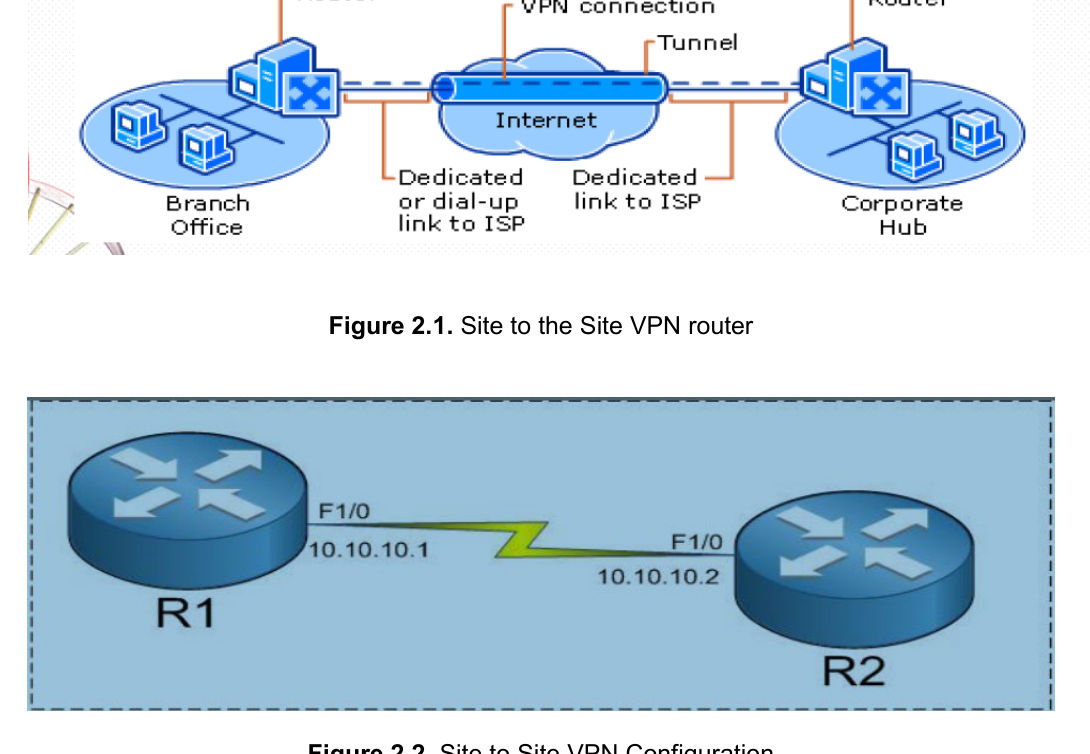
Figure 2.2. Site to Site VPN